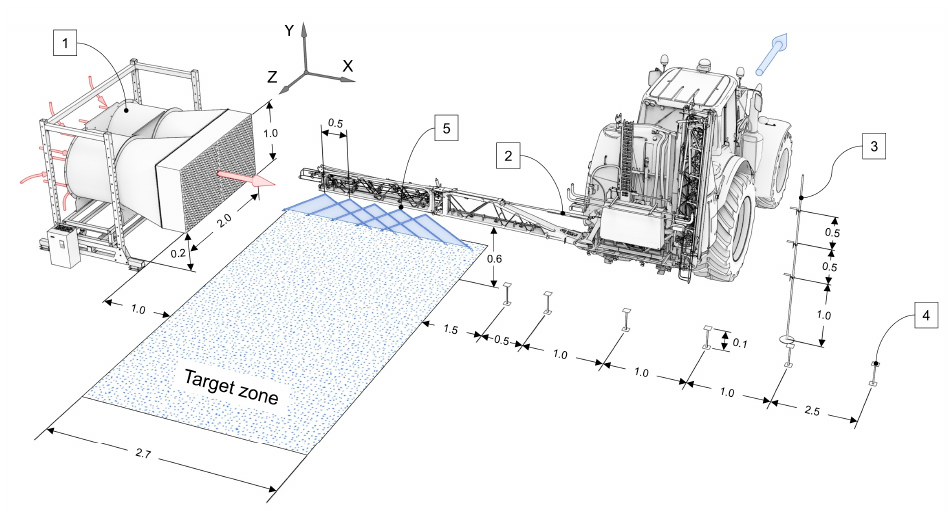
Figure 3. Setup for field spray drift experiments: 1—fans with frequency converters and air flow straighteners 0.25 m in length; 2—sprayer boom; 3—airborne spray drift setting rod with water sensitive paper attachment points; 4—ground spray drift stands with water sensitive paper attachment points; 5—nozzle. Note: ground spray drift stands at 10, 15, and 20 m away from the spraying area of the sprayer are not shown in the picture.